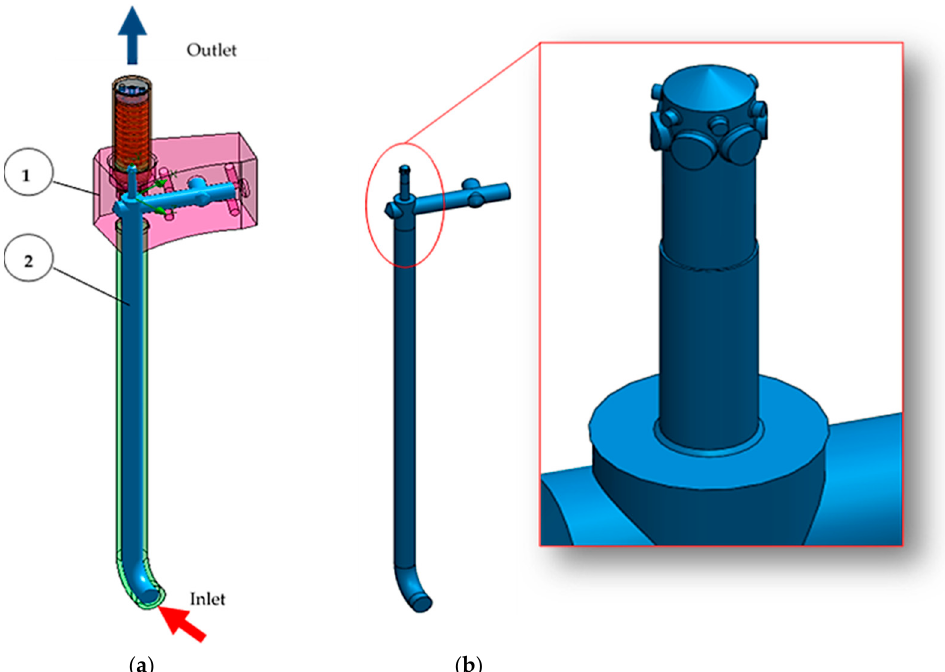
Figure 6. The major steps of the fluid volume separating process: ( a )- geometry model of the overflow valve, ( b )- separated volume of fluid, 1- safety element, 2- volume of fluid.